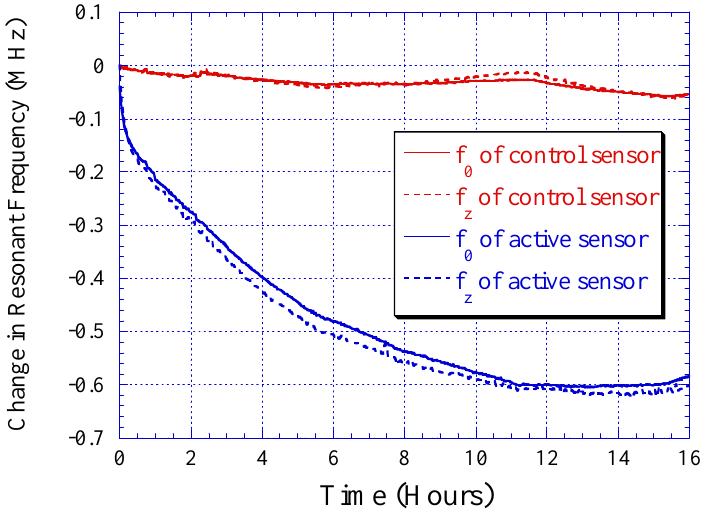
Figure 8. Changes in f and f when the active sensor was embedded inside an opened 0 z Kellogg’s Cocoa Krispies cereal package, while the control sensor was within a sealed cereal package of the same